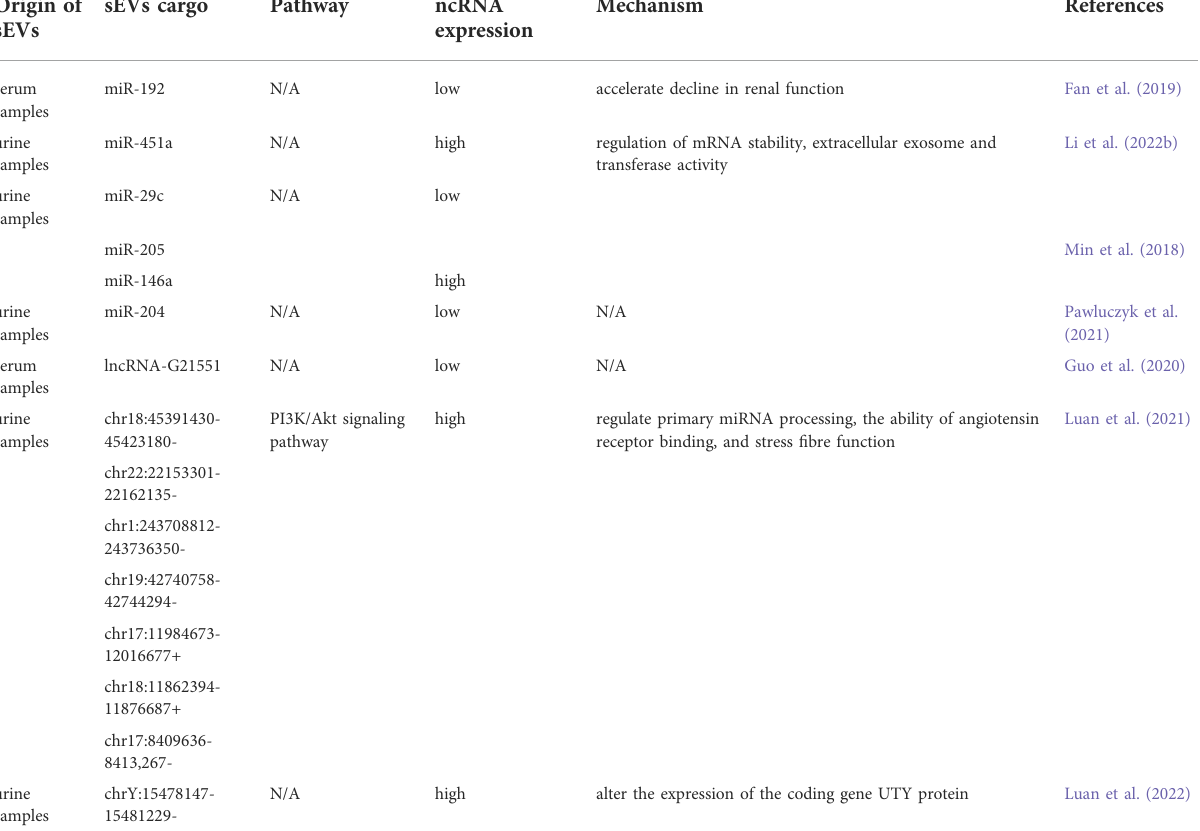
TABLE 3 The role of small extracellular vesicle non-coding RNAs in IgA nephropathy. Origin of